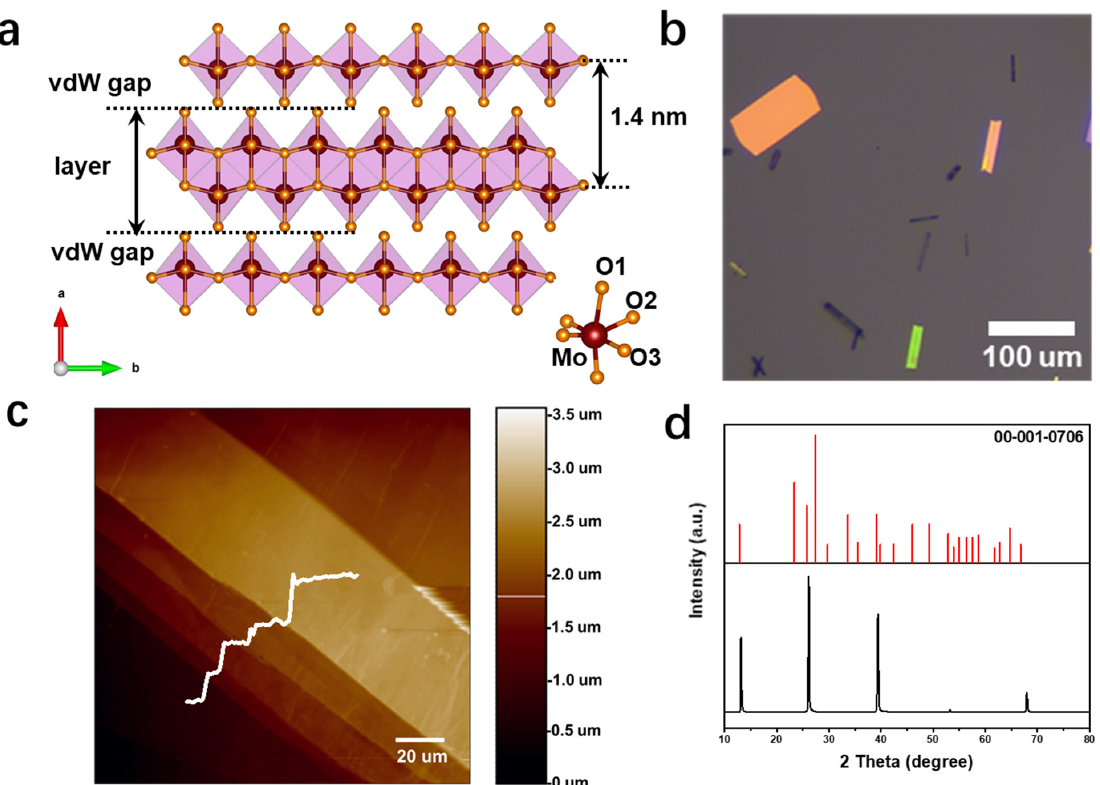
Figure 1. ( a ) MoO 3 lattice structure diagram. ( b ) Optical microscope image of MoO 3 nanosheets grown by vapor deposition method. ( c ) AFM surface topography of MoO 3 nanosheets. ( d ) XRD spectrum of MoO 3 nanosheets.